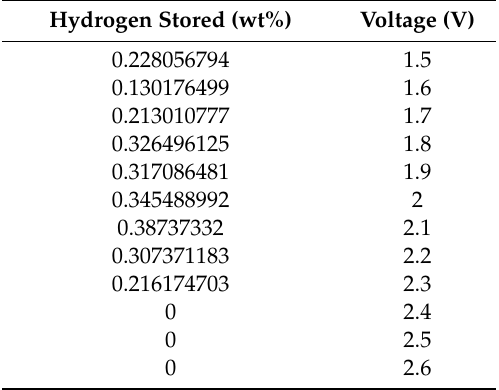
Figure 15. Graph showing relation between wt% of hydrogen stored in carbon and voltage during charging of modified URFC or proton battery. Table 10. X and Y axis variable values of the active points shown in Figure 15.